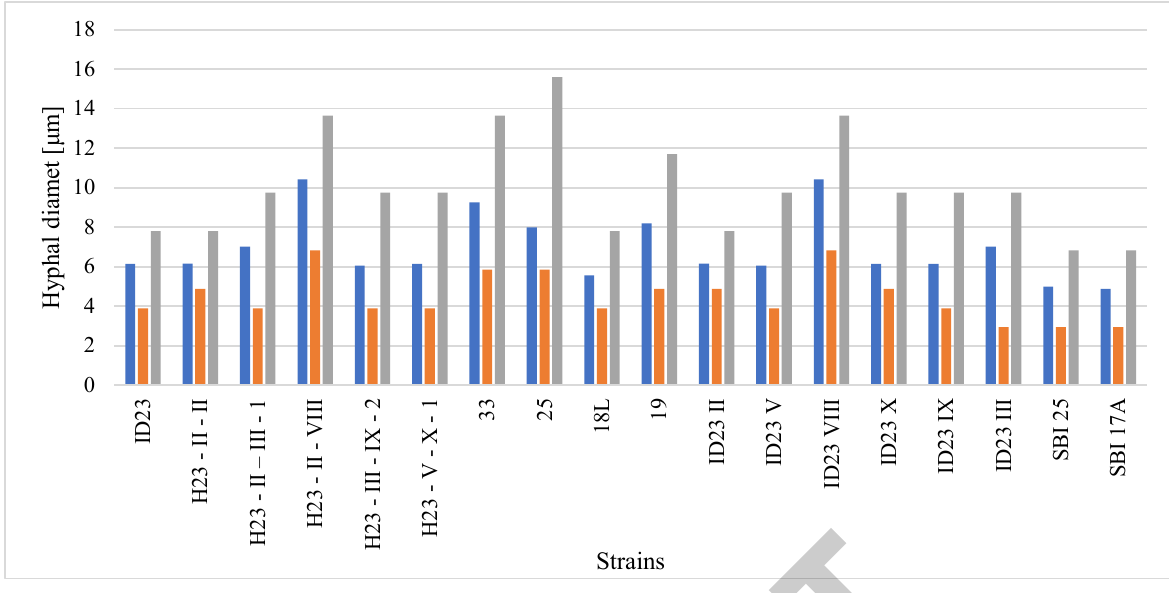
Figure 3 . Hyphal diameter of selected monokar yons and heterokaryons of R. solani AG5 ( µ m) Fungicides. Tw o fungicide concentration s were used in this study: 10 ppm of active substance, which refers to the possible field concentration of the preparations, and 100 ppm